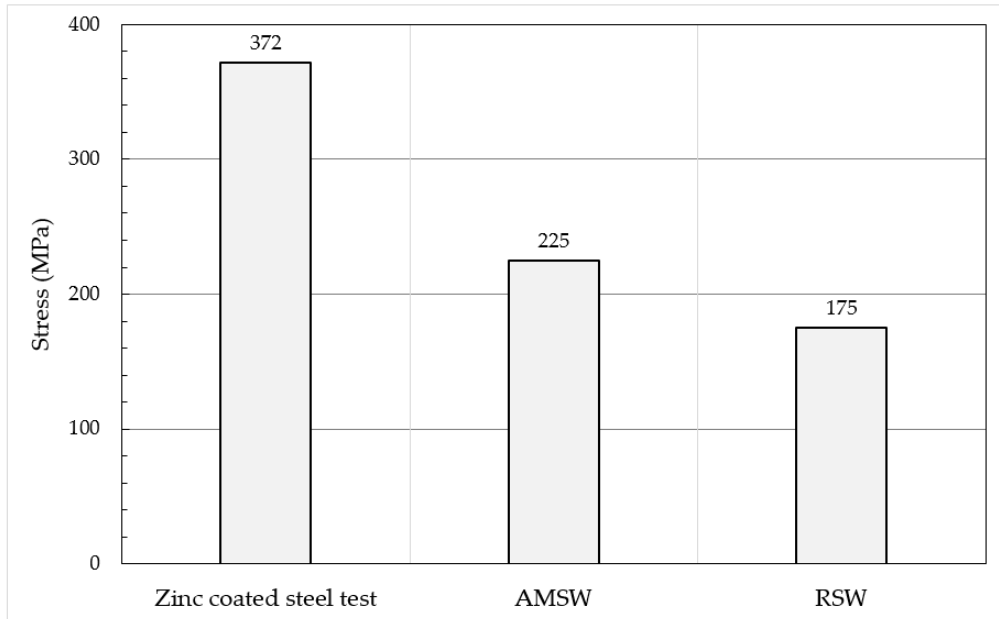
Figure 11. Comparison of maximum tensile stresses of weld points under cross-tension test, between spot welding process using additive manufacturing (AMSW) and the resistance spot welding process (RSW), in relation to the maximum tension of the zinc coated sheet .